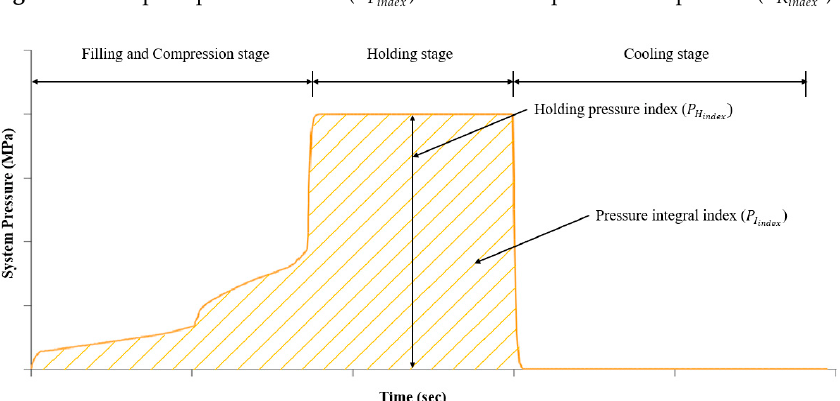
Figure 11. The peak pressure index ( 𝑃 (cid:3017)